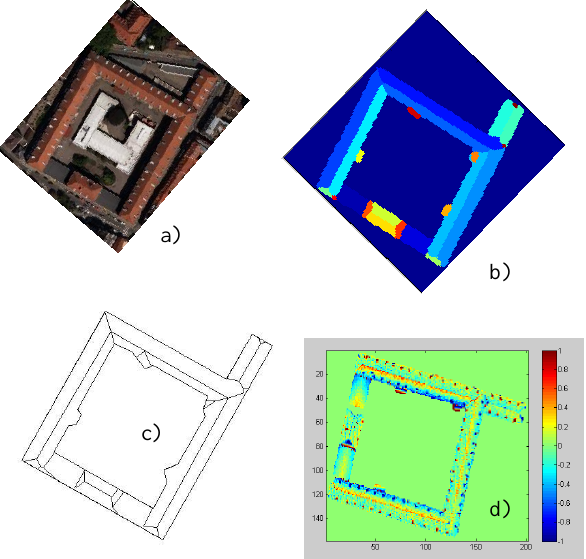
Figure 11. a) Building aerial image; b) Building label image; c) 2D roof model; d) Error map visualisation; this building is in Strasbourg